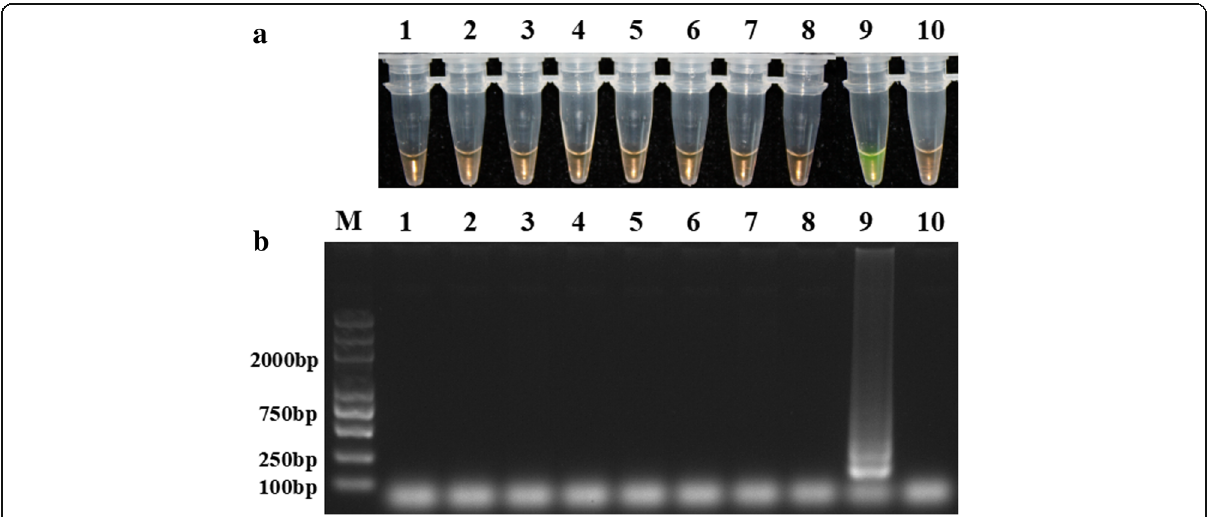
Fig. 4 Specificity of a LAMP primer set for detection of E198V mutation in Botrytis cinerea. a LAMP products detected with 1000 × SYBR Green I. b LAMP assessment based on agarose gel electrophoresis. Lane M: DNA 2 K plus Marker; tubes and lanes 1 – 9: B. sinoviticola , B. sinoallii , B. porri , Monilia fructicola , M. mumecola , M. yunnanensis , Fusarium graminearum , Sclerotinia sclerotiorum , and B. cinerea (E198V); tube and lane 10: ddH 2